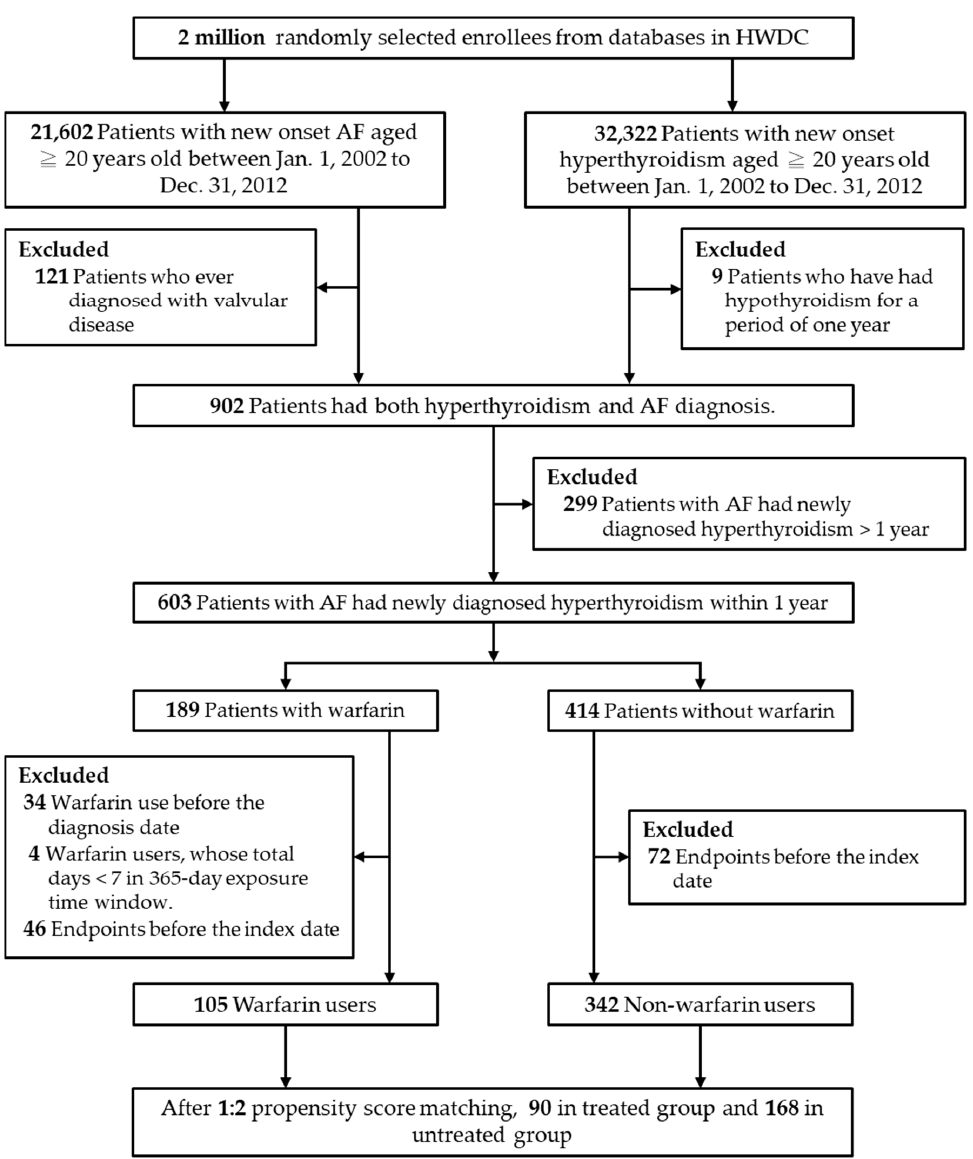
Figure 1. Flowchart of the study and analysis. Abbreviations: AF, atrial fibrillation; HWDC, Health and Welfare Data Science